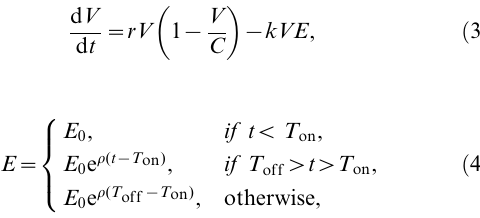
Table 1. Estimates of parameters of the mathematical model fitted to the data from the adoptive transfer